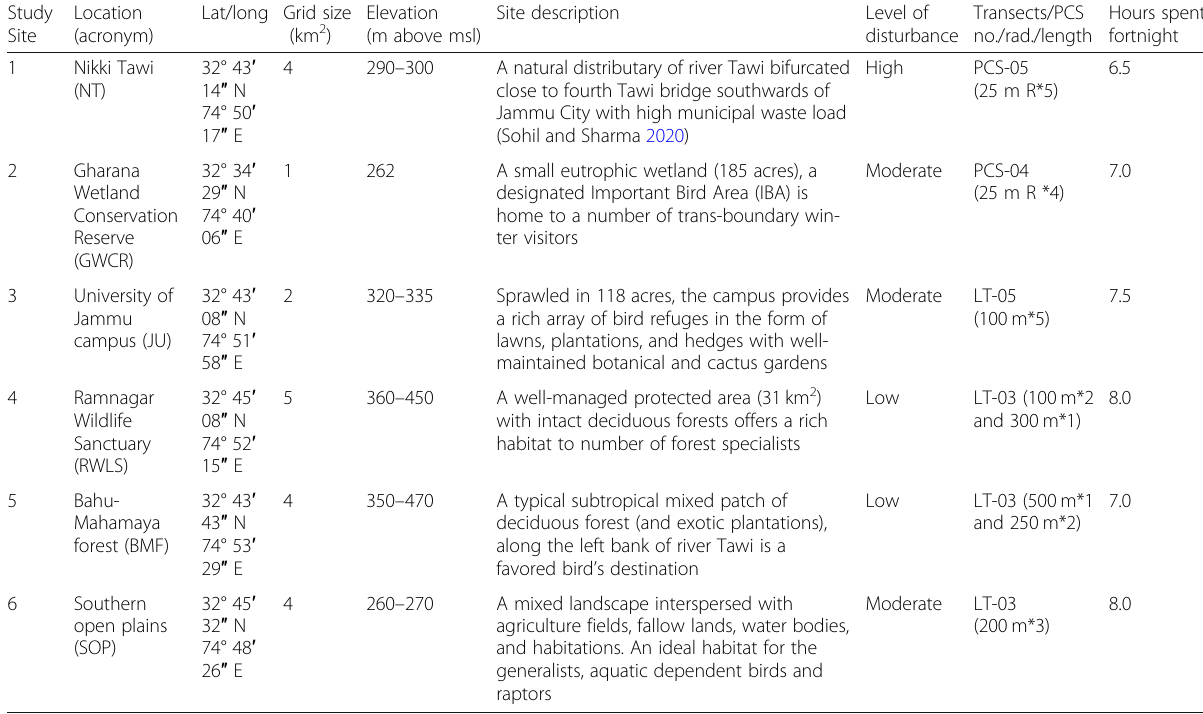
Table 1 Characteristic features of sampling sites with details on geo-features, sampling size, and the level of